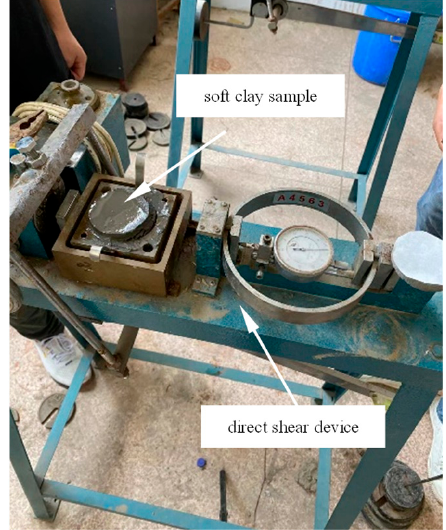
Figure 3. Layout of electro-osmosis from top to bottom.